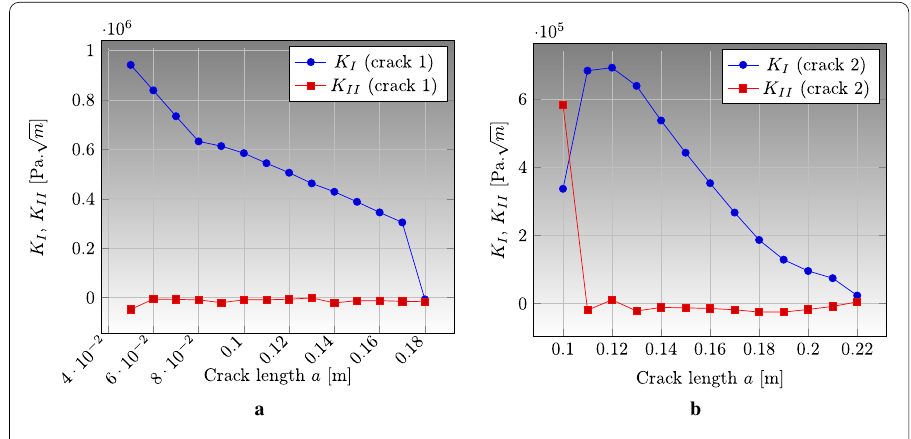
Fig. 24 Crack growth in plate with two circular holes and multiple cracks: stress intensity factors K I and K II ; a crack 1, b crack